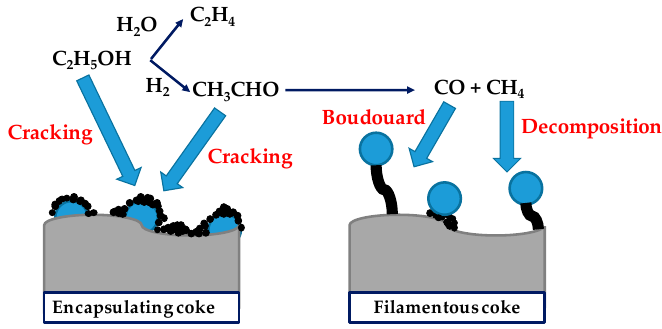
Figure 3. Mechanism and nature of coke formed over Ni/La 2 O 3 - α Al 2 O 3 [22].